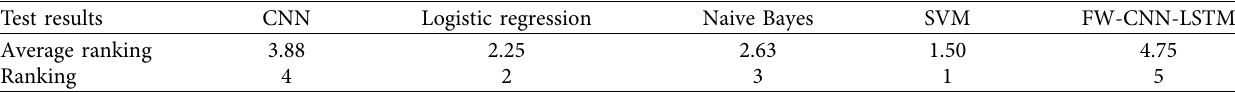
Table 11: Average ranking of Friedman’s test for the comparing algorithms of the Instagram